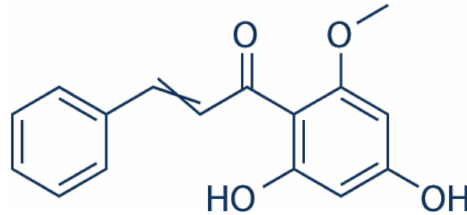
Figure 15. The chemical structure of